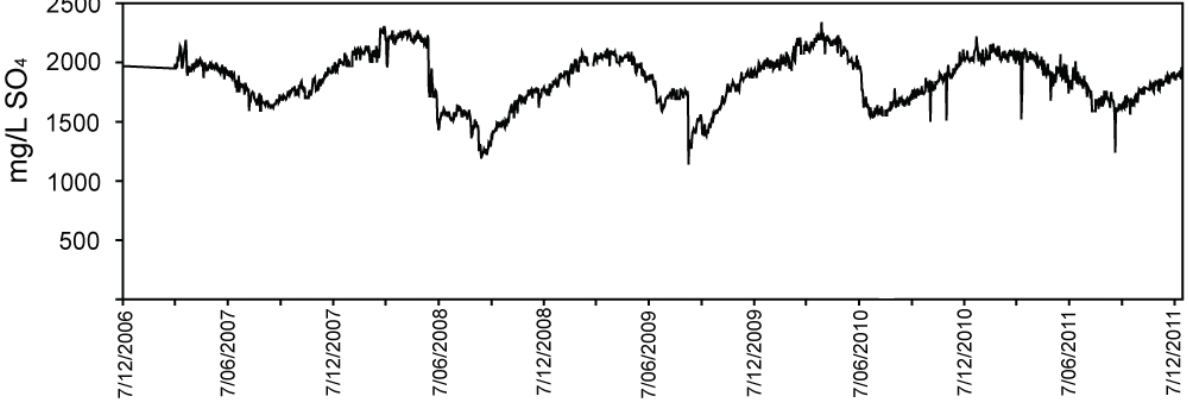
Figure 2. Example of the evolution of dissolved sulphate concentrations (in mg/L) in the decantation pond of an active tailings impoundment during a five year period. A clear seasonal trend is observed, peaking end of summer due to evaporation